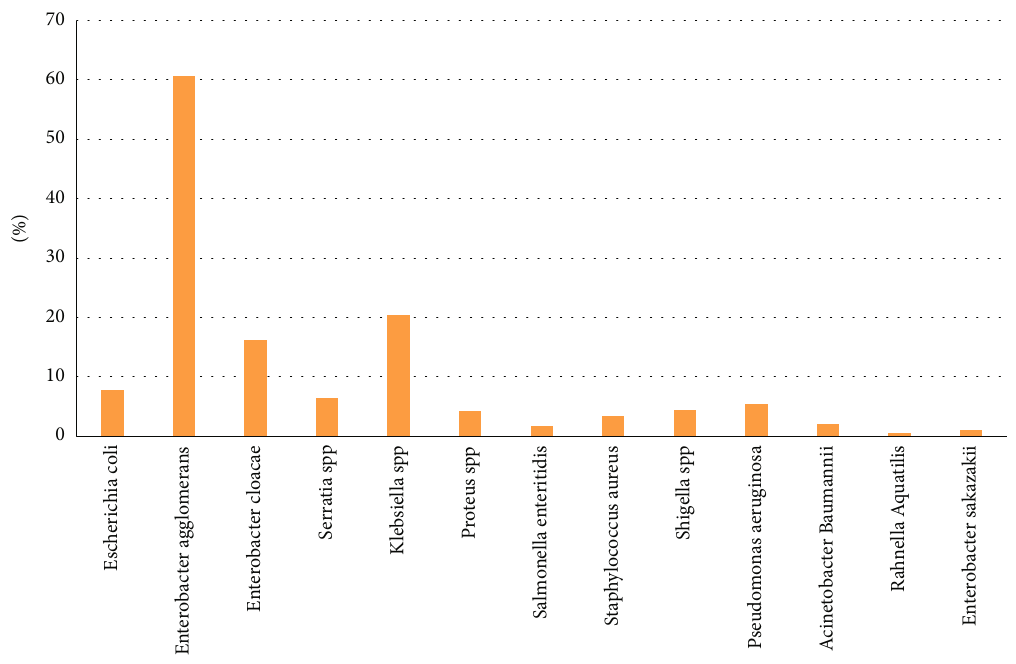
Figure 1: Distribution of bacterial organisms identi fi ed from all eggs ’ samples.